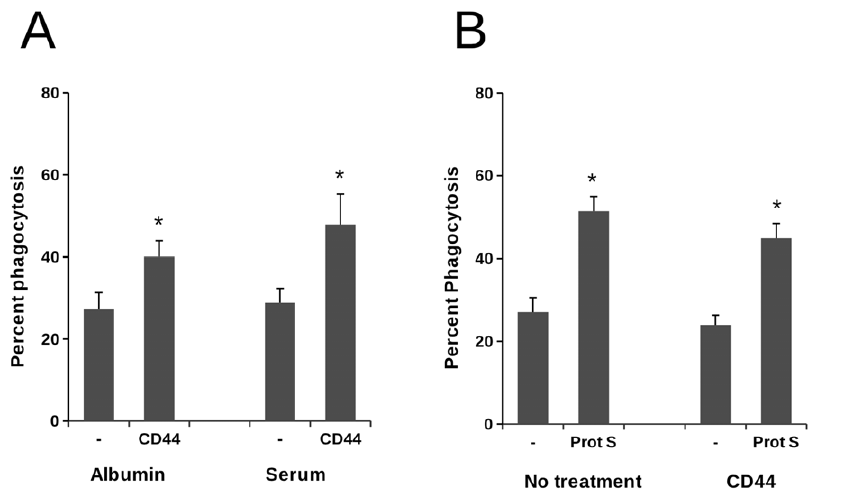
Figure 3. CD44 promotes a serum-opsonin independent mechanism of phagocytosis of apoptotic neutrophils. A) Monocyte-derived macrophages were incubated in the absence or presence of CD44 mAb for 30 min prior to addition CMFDA-labelled neutrophils that had been cultured either in human serum albumin (Albumin) or autologous serum (Serum). Assessment of phagocytosis was made by flow cytometry, data are mean 6 SEM from 5 independent experiments. Although CD44 augmented phagocytosis relative to untreated cells (*=p , 0.05), no significant differences between phagocytosis of PMN cultured in albumin versus serum was found following CD44 treatment. B) Glucocorticoid-treated monocyte-derived macrophages were incubated in the absence or presence of CD44 mAb for 30 min prior to addition CMFDA-labelled neutrophils that had been cultured in human serum albumin. Phagocytosis was assessed in the presence of 100 ng/ml of protein S for 30 min and the proportion of phagocytic macrophages determined by flow cytometry. Data shown are mean percentage phagocytosis 6 SEM from 5 independent experiments. Although the presence of protein S augmented phagocytosis by glucocorticoid-treated macrophages (*=p , 0.05), there was no significant difference between phagocytosis of PMN in the presence or absence of protein S following CD44 treatment.